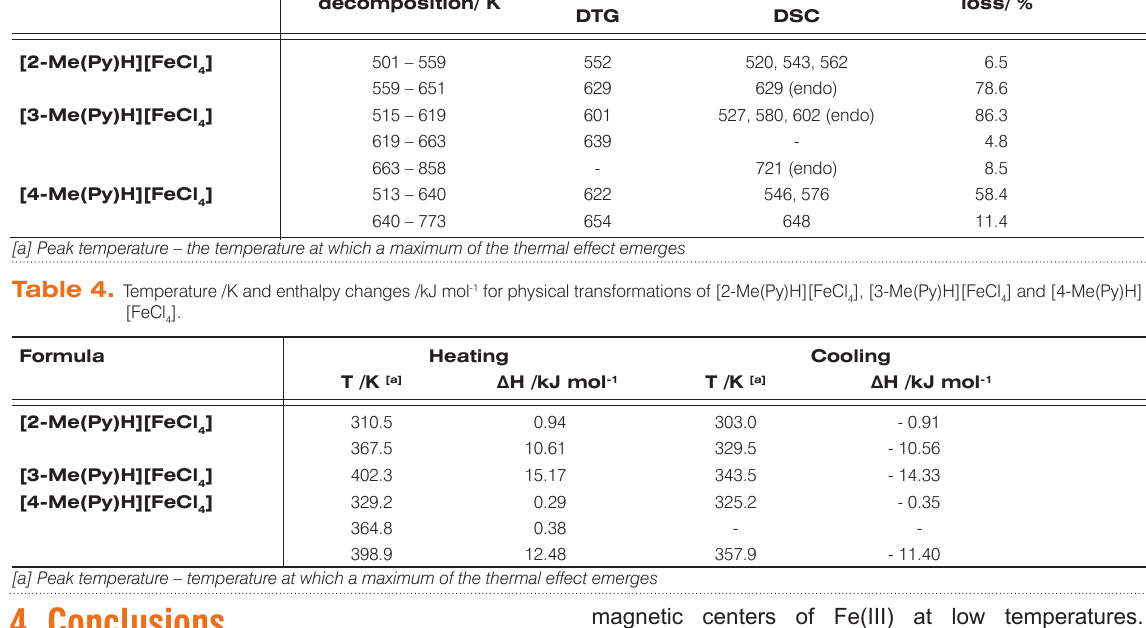
] (1), [3-Me(Py)H][FeCl ] (2) and [4-Me(Py)H][FeCl 4 4 ], [3-Me(Py)H][FeCl ] and [4-Me(Py)H][FeCl ] in argon. 4 4 4 decomposition/ K